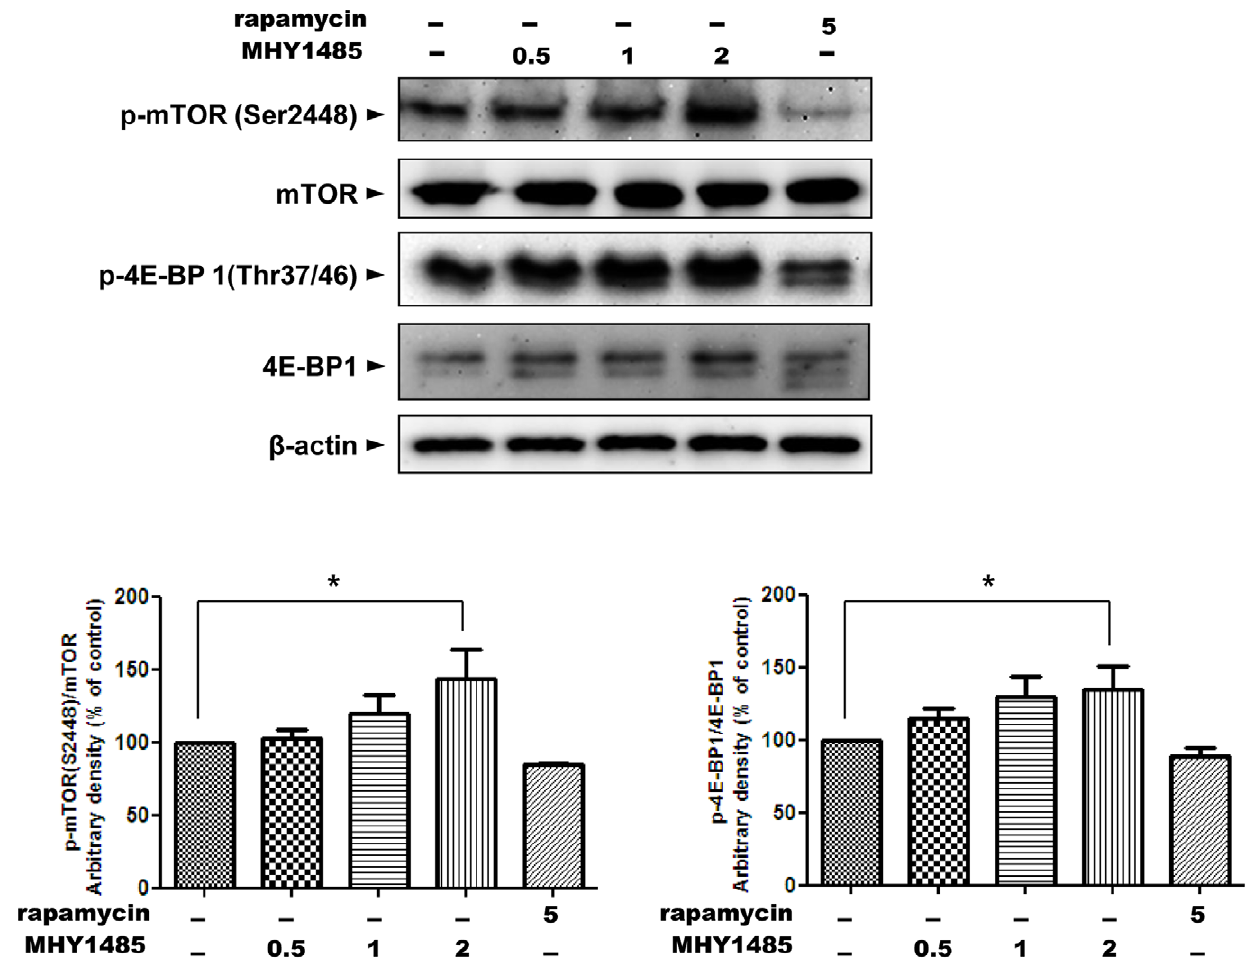
Figure 6. Activation of mTOR by MHY1485. Western blot analysis was performed to detect the change of total protein level and levels of phosphorylated forms of mTOR and 4E-BP1 reflecting the activity of mTOR. Ac2F cells were treated with MHY1485 of different concentrations and rapamycin 5 m M as a positive control for 1 h. Bars represent the phospho-mTOR(Ser2448)/mTOR ratio and the phospho-4E-BP1(Thr37/46)/4E-BP1 ratio normalized with the ratio from untreated samples, respectively. b -Actin blot is shown to verify the same amount of protein loaded. The blots were quantified by densitometry expressed as mean 6 SD (*p , 0.05; n=3).